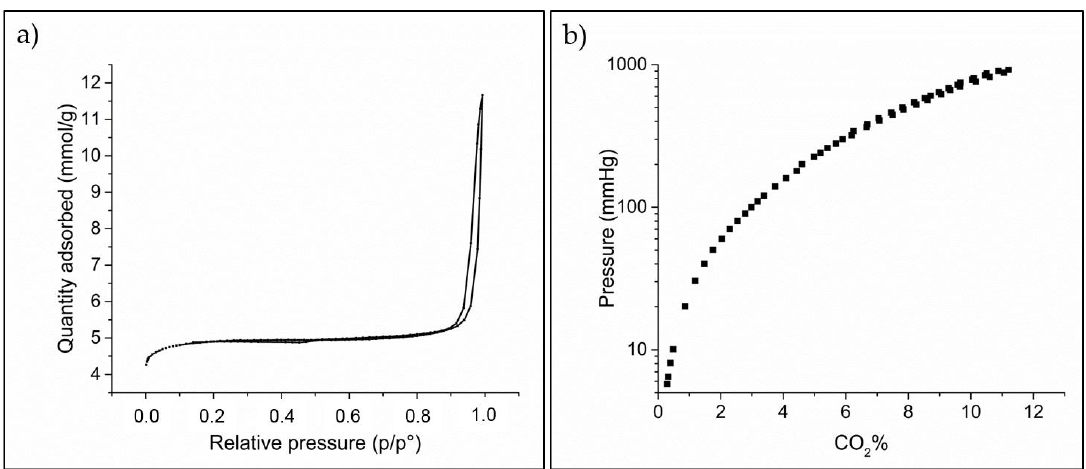
Figure 5. ( a ) N 2 adsorption isotherm of TiO 2 /HKUST-1 at T = 77 K; ( b ) Pressure–composition plot for CO 2 physisorption on TiO 2 /HKUST-1 at T = 303 K.